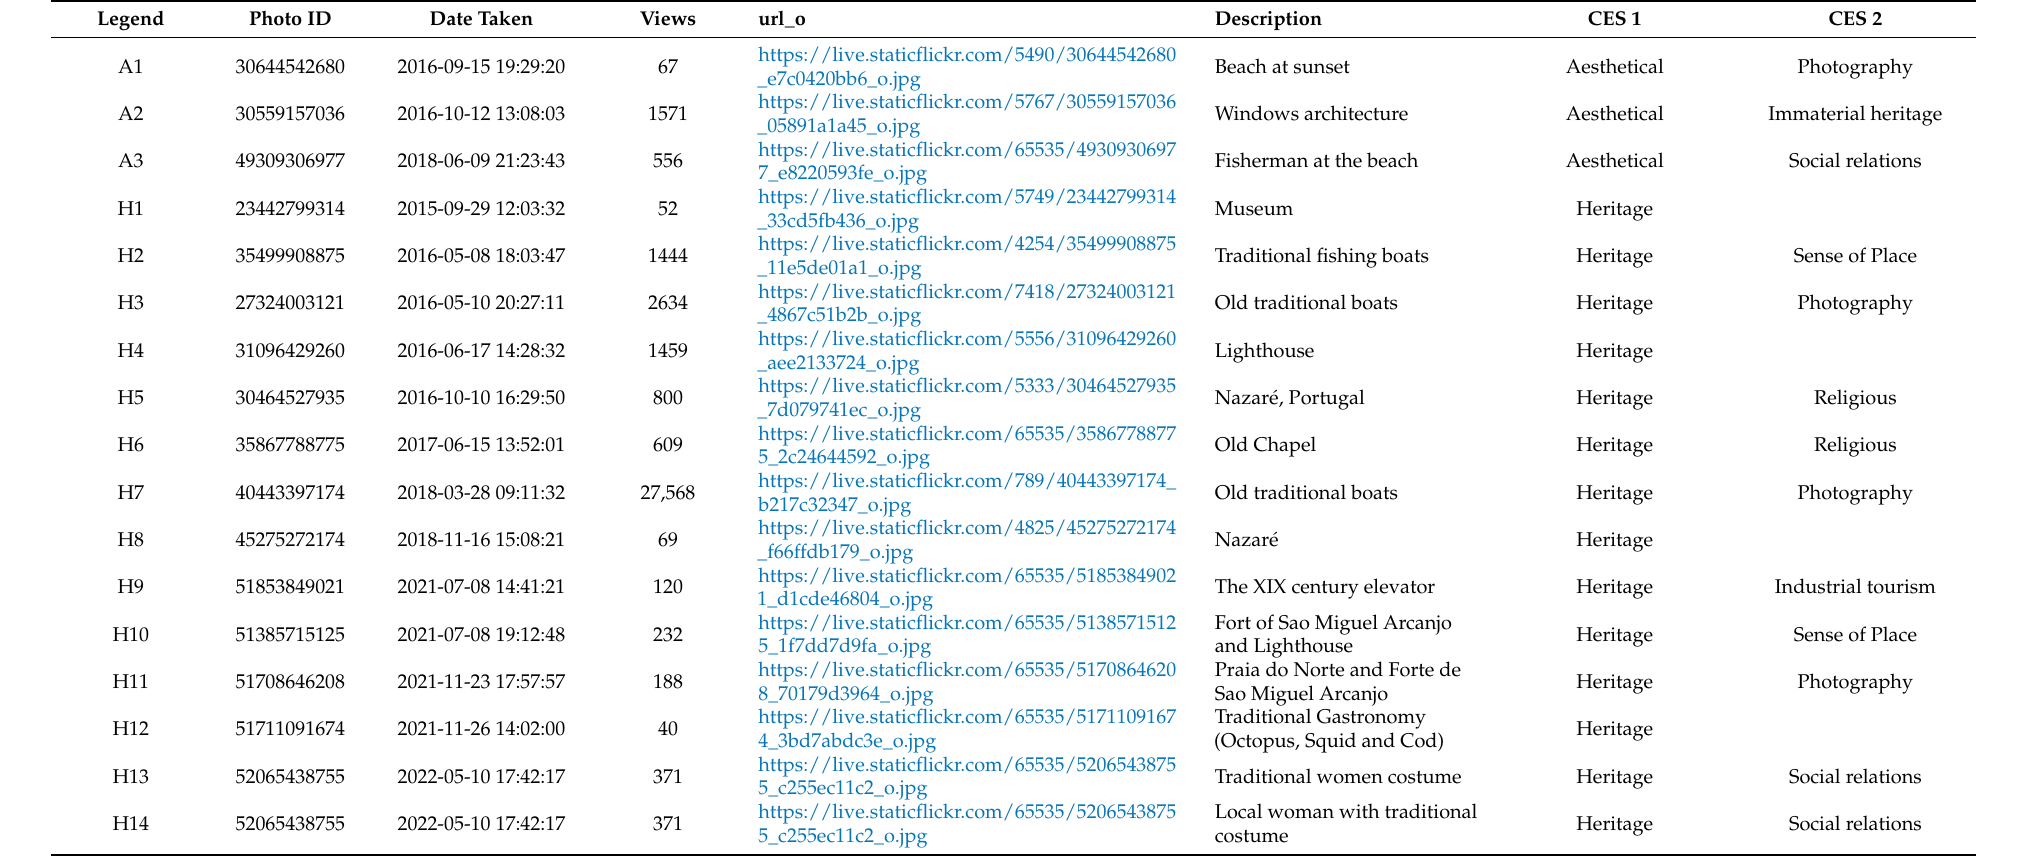
Table 4. Cultural Ecosystem Services (CES1 and CES2) depicted in the selection of photos retrieved by the Flickr API method flickr.photos.search (all accessed on 31st October